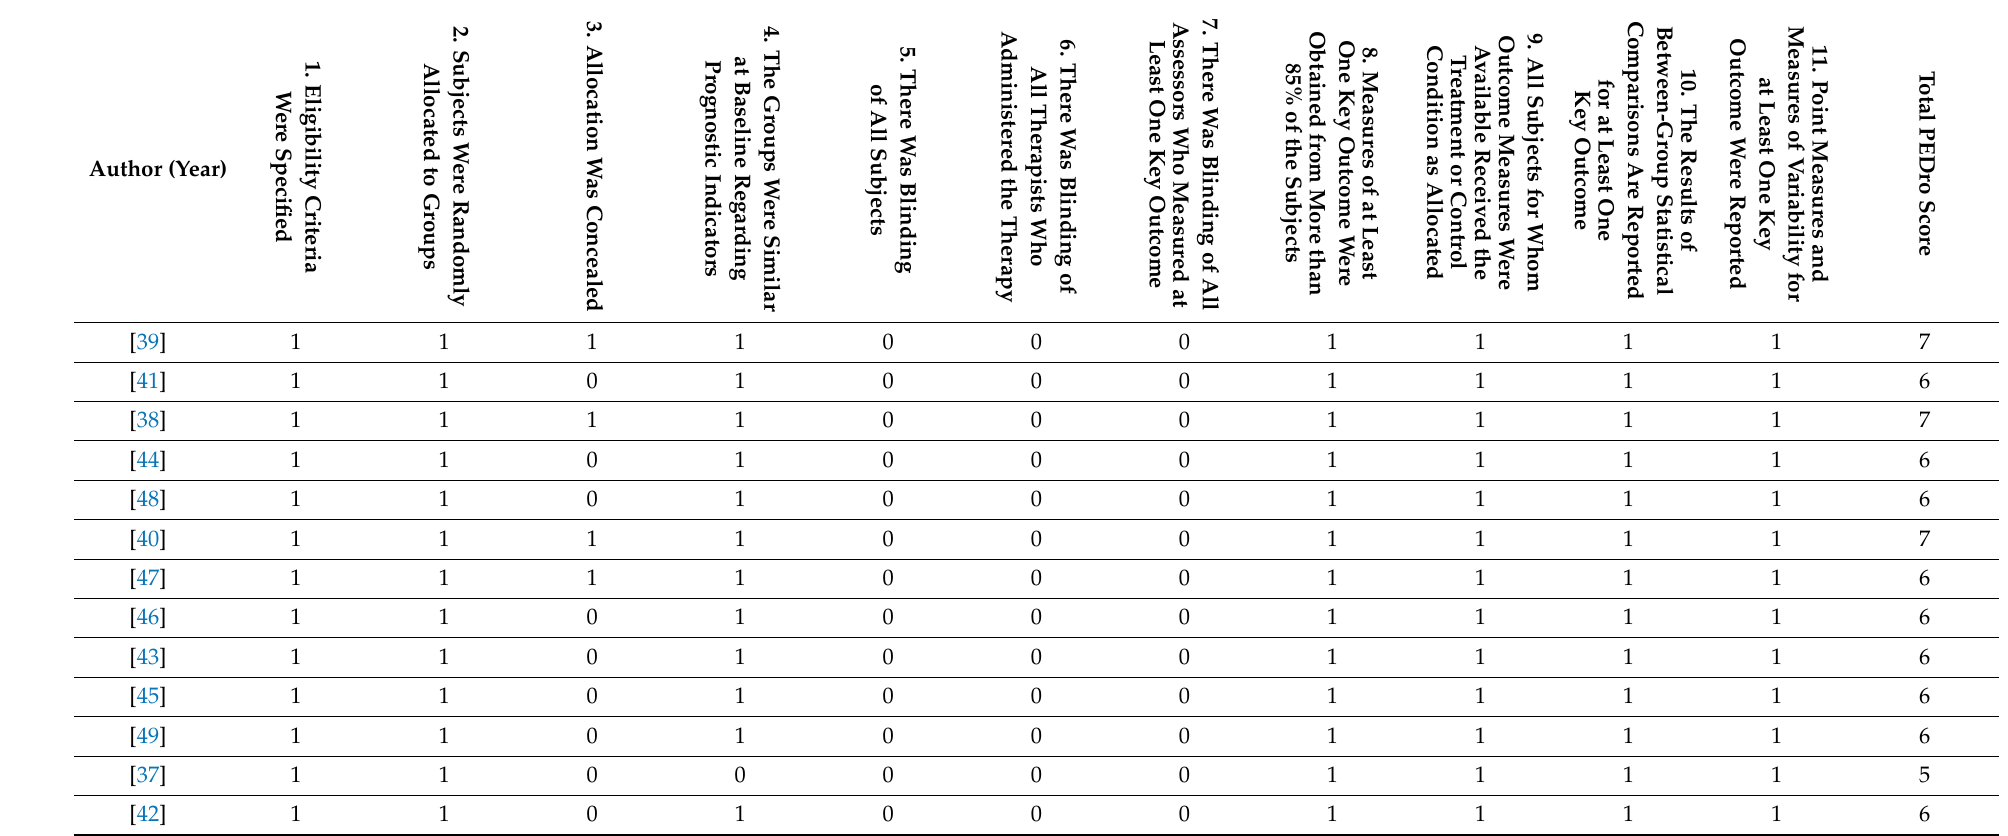
Table 3. Results of the PEDro scale for quality assessment for the included randomised controlled